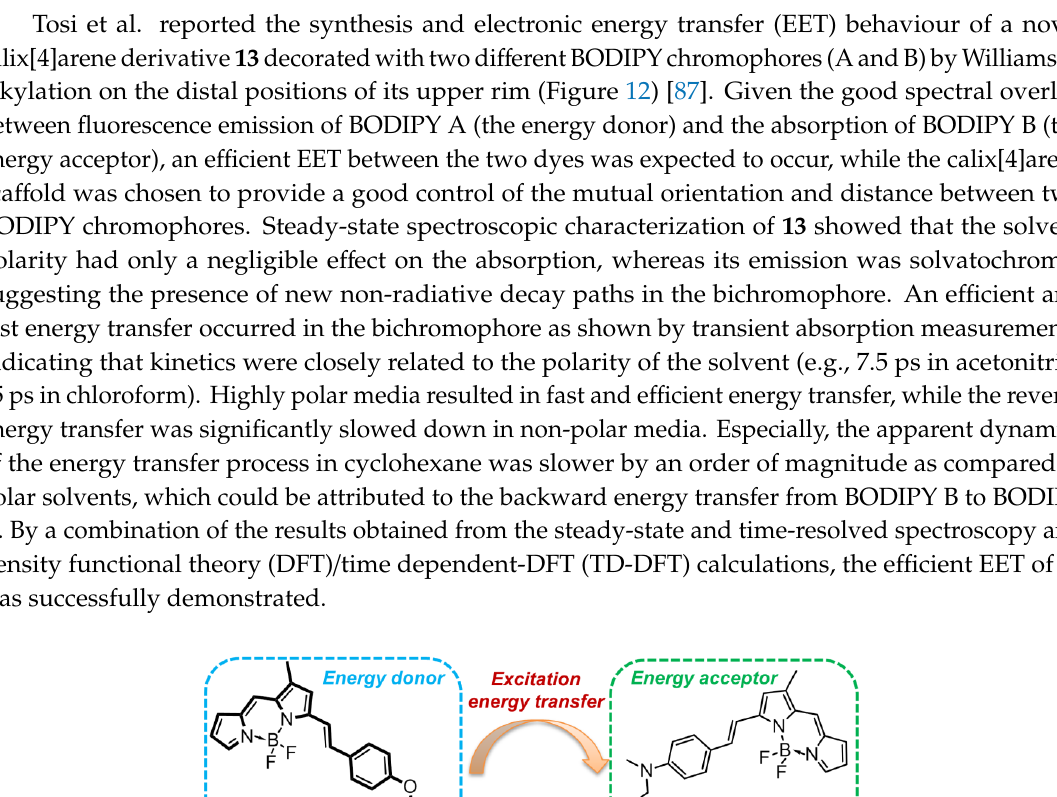
Figure 11. Chemical structure of BODIPY functionalized calix[4]arene 12 .